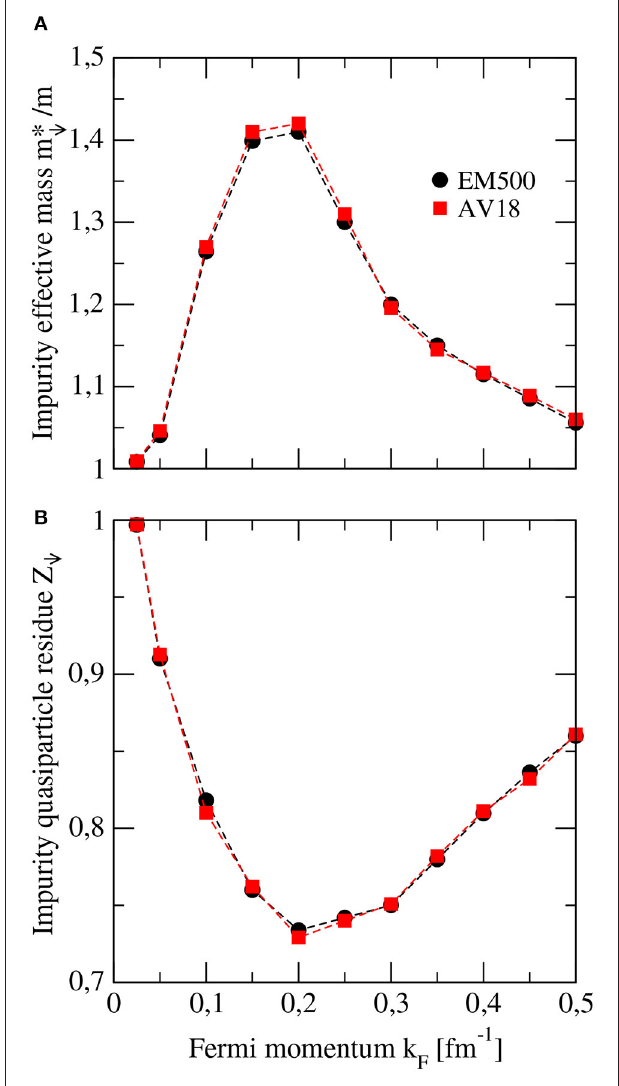
FIGURE 5 | Effective mass (A) and quasiparticle residue (B) of a ↓ neutron impurity with zero momentum as a function of the Fermi momentum of the free gas of ↑ neutrons. Results are shown for the EM500 interaction (full circles) and the AV18 potential (full